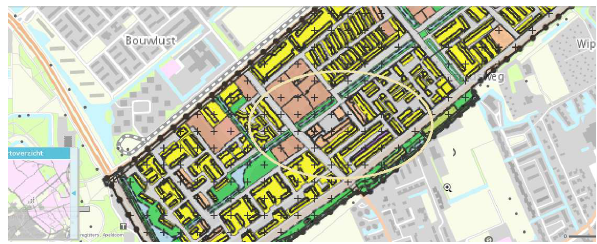
Figure 1. Spatial planning map with 2D planning objects as viewable on “http://www.ruimtelijkeplannen.nl”